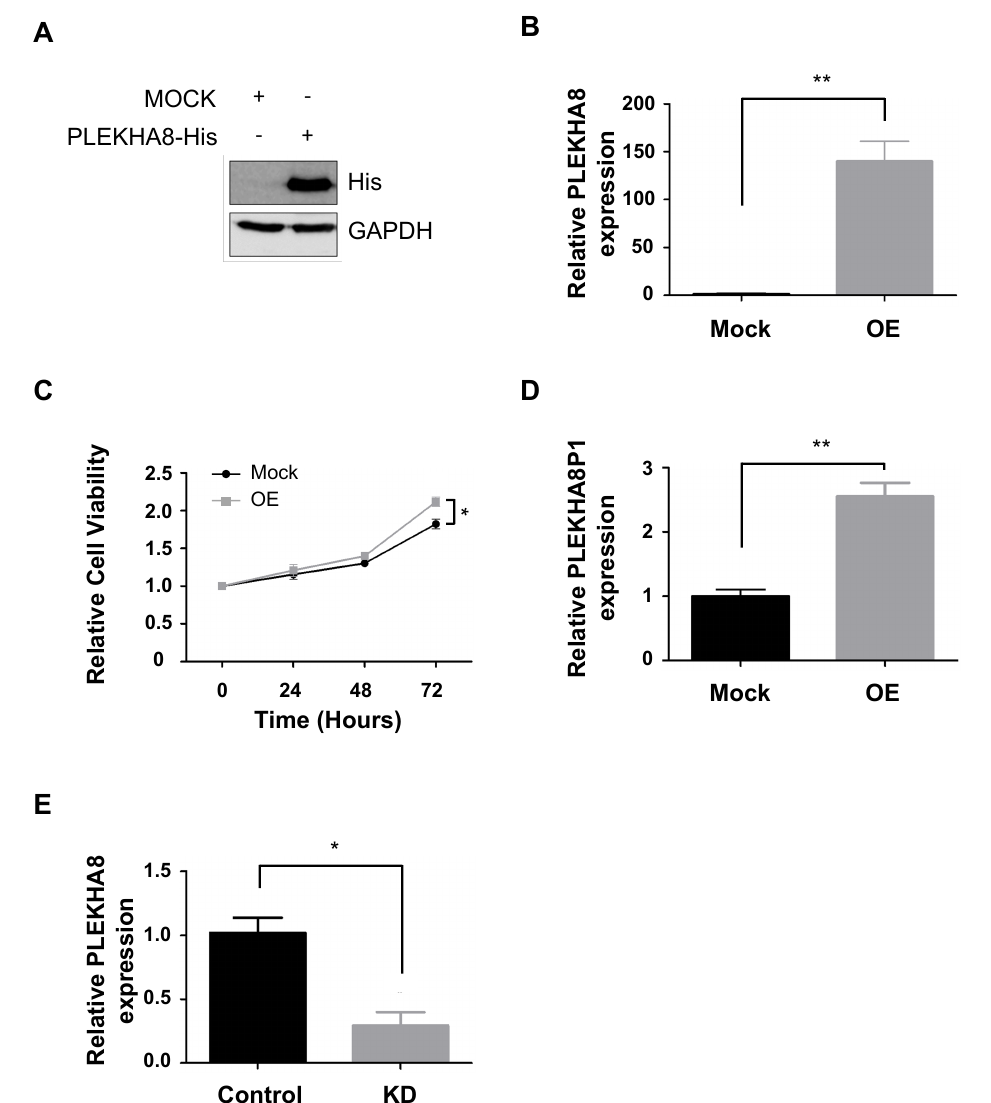
Figure 5. Overexpression of PLEKHA8 promotes proliferation of liver cancer cells. ( A ) PLEKHA8 mRNA level was assessed in PLEKHA8P1 knockdown cells by RT-qPCR. ( B ) Overexpressed PLEKHA8 was confirmed by Western blot analysis 48 h after transfection. ( C ) Overexpressed PLEKHA8 was veri- fied via RT-qPCR 48 h after transfection. ( D ) CCK-8 assays were performed to determine cell viability at indicated time-points (0, 24, 48, 72 h). ( E ) PLEKHA8P1 expression level was assessed in PLEKHA8 overexpressed cells by RT-qPCR. All data were acquired from three independent experiments and p -values were determined by two-tailed unpaired t -test analysis. * p < 0.05; ** p <0.01. Our results thus demonstrate that a PLEKHA8P1-PLEKHA8 axis could exert a cytopro- tective effect against 5-FU, thus connoting both molecules as novel therapeutic targets in HCC-related chemoresistance